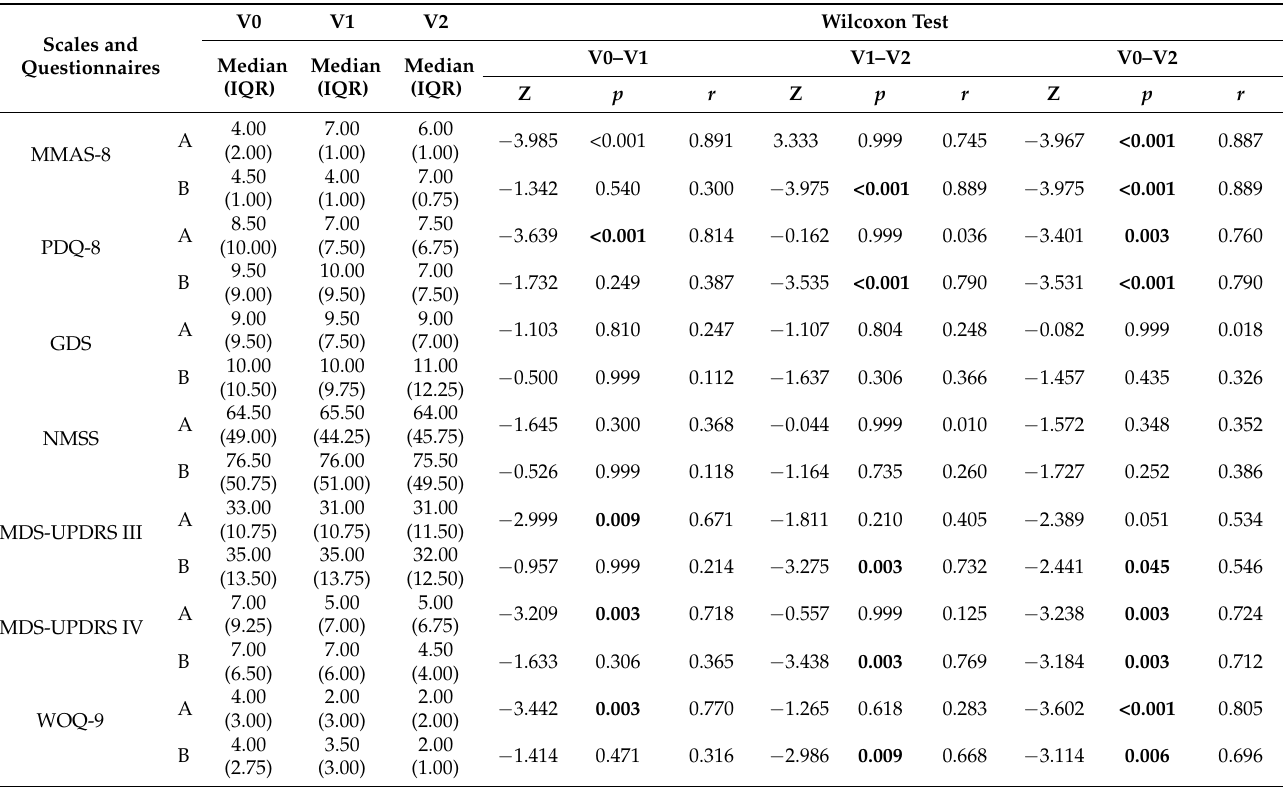
Table 2. Effect of intervention with pillbox organizer with alarm (Wilcoxon